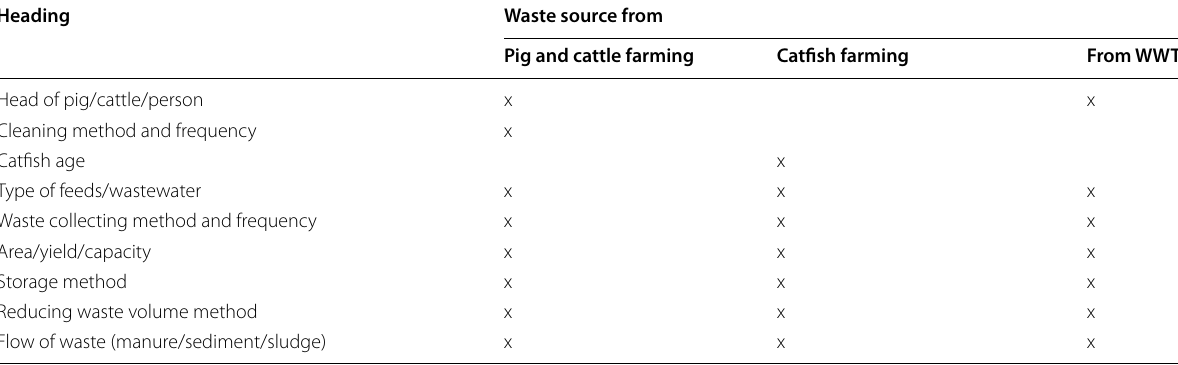
Table 1 Main input data collected via field survey